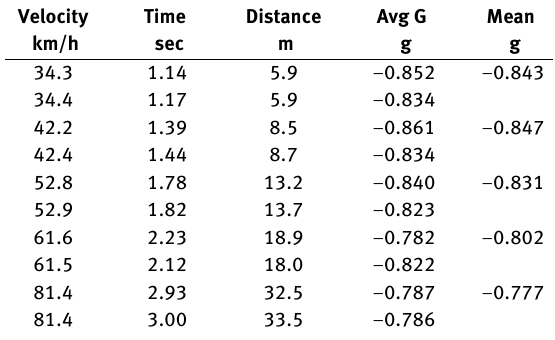
Table 2. Average friction coefficient of a vehicle sliding on bitumen with antilock braking system disabled (ABS off)